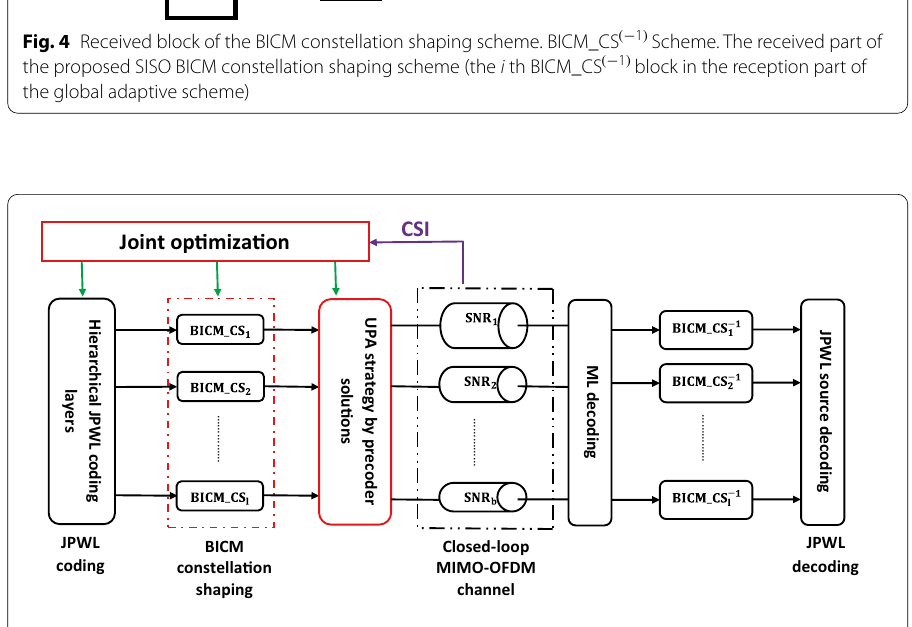
Fig. 5 The proposed adaptive MIMO-OFDM scheme for JPWL image transmission. Description of the different blocs in the proposed adaptive MIMO-OFDM